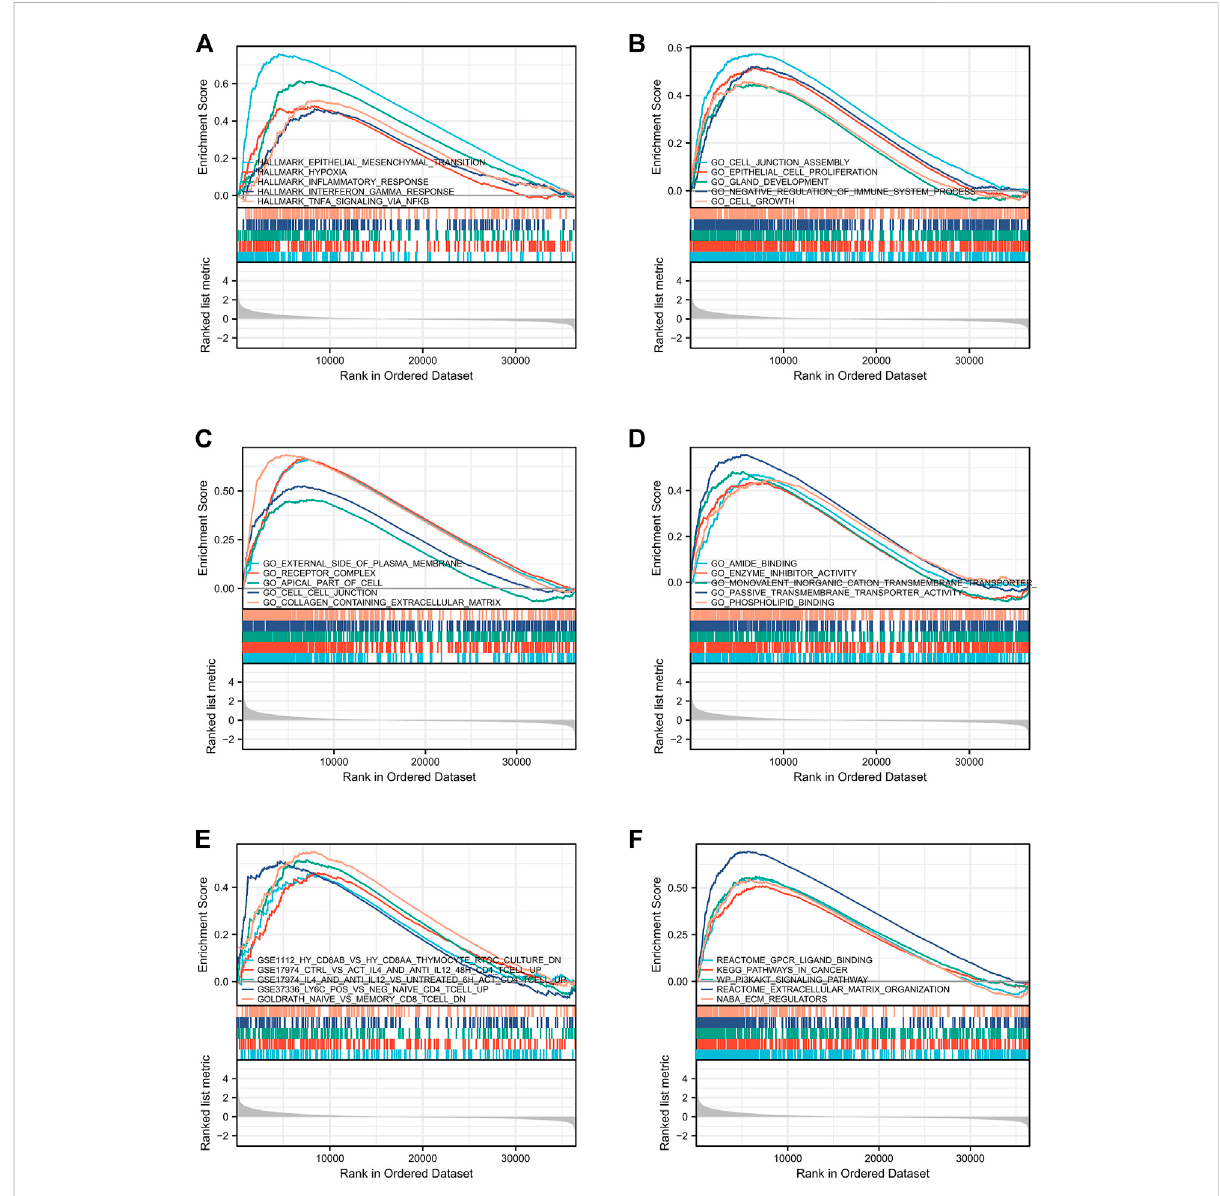
FIGURE 5 Enrichment plots from GSEA. The pathways associated with LMO3 expression based on hallmark gene sets (A) , GO terms (B – D) , C7 collection (E), and KEGG terms (F)